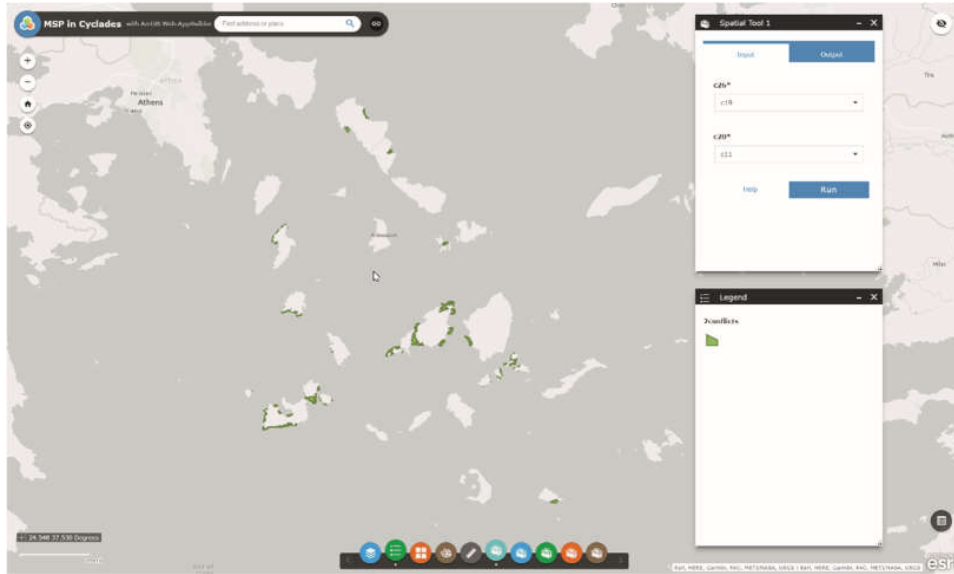
Figure 3. Areas where the conflicts ‘C19: Purse seining—Marine protected areas (Natura 2000)’ and ‘C11: Coastal fishing—Areas covered by Posidonia oceanica ’ co-exist.